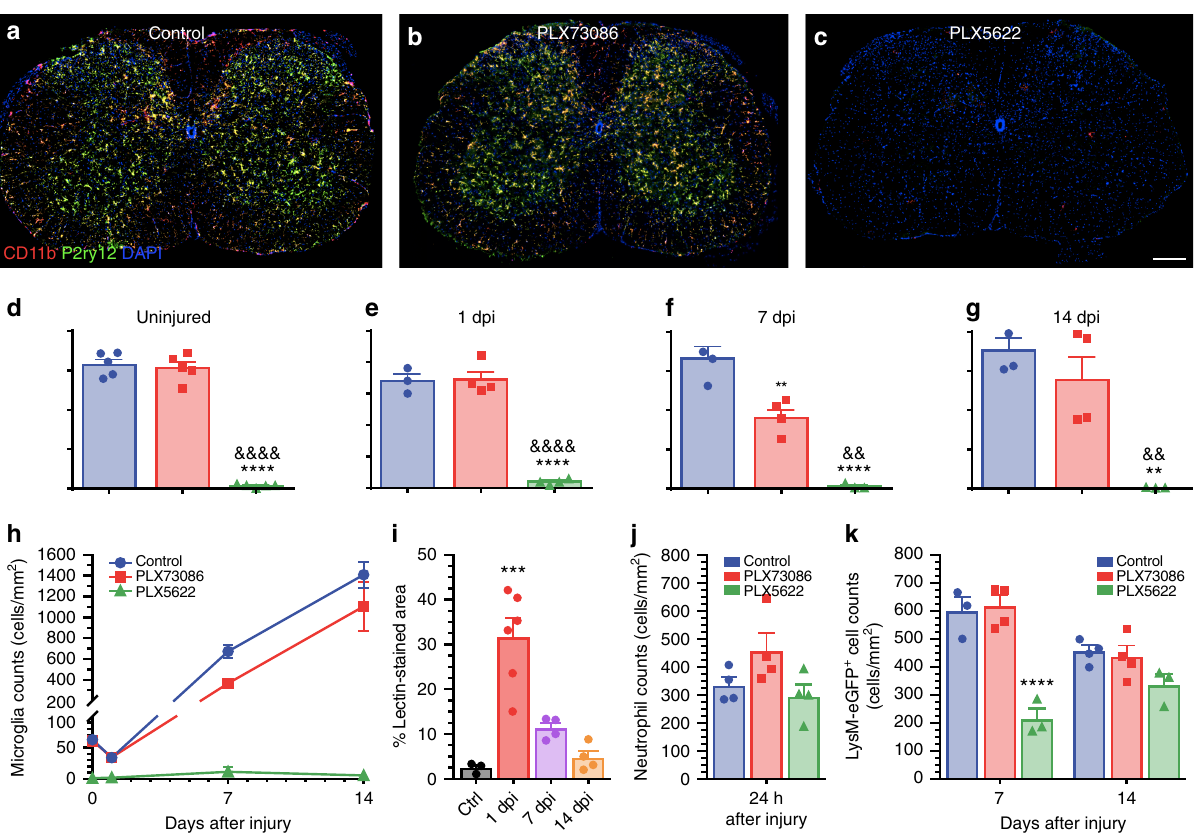
Fig. 2 The CSF1R inhibitor PLX5622, but not PLX73086, crosses the blood – spinal cord barrier to deplete virtually all microglia. a – c Representative confocal images of CD11b and P2ry12 immunostainings showing the almost complete elimination of microglia in the spinal cord of naïve (uninjured) C57BL/6 mice after treatment with the CSF1R inhibitor PLX5622 compared to those fed PLX73086 or the control diet. Mice were killed after 21 days of treatment. d – h Quanti fi cation of microglia in the spinal cord of uninjured C57BL/6 mice treated with PLX5622, PLX73086 or the control diet ( d ), as well as at the lesion epicenter in Cx3cr1 creER :: R26 - TdT mice killed at 1 ( e ), 7 ( f ), and 14 ( g ) days post-injury (dpi) ( n = 4 – 5 mice per group/time point). i Quanti fi cation of the proportional area of spinal cord tissue permeable to FITC-conjugated lectin injected intravenously prior to tissue fi xation. j Quanti fi cation of Ly6G + neutrophils at the lesion epicenter at day 1 post-SCI in mice treated with either PLX5622, PLX73086, or the control chow ( n = 4 – 5 per group). k Quanti fi cation of the number of granulo-myelomonocytic cells at the lesion epicenter at 7 and 14 dpi in Cx3cr1 creER :: R26-TdT :: LysM -eGFP mice treated with either PLX5622, PLX73086, or the control diet ( n = 4 – 5 mice per group/time point). For all injured mice, treatment was initiated 3 weeks before SCI and continued until sacri fi ce. Data are expressed as mean ± SEM. ** p < 0.01, *** p < 0.001, **** p < 0.0001, PLX5622 or 1 dpi compared to the control